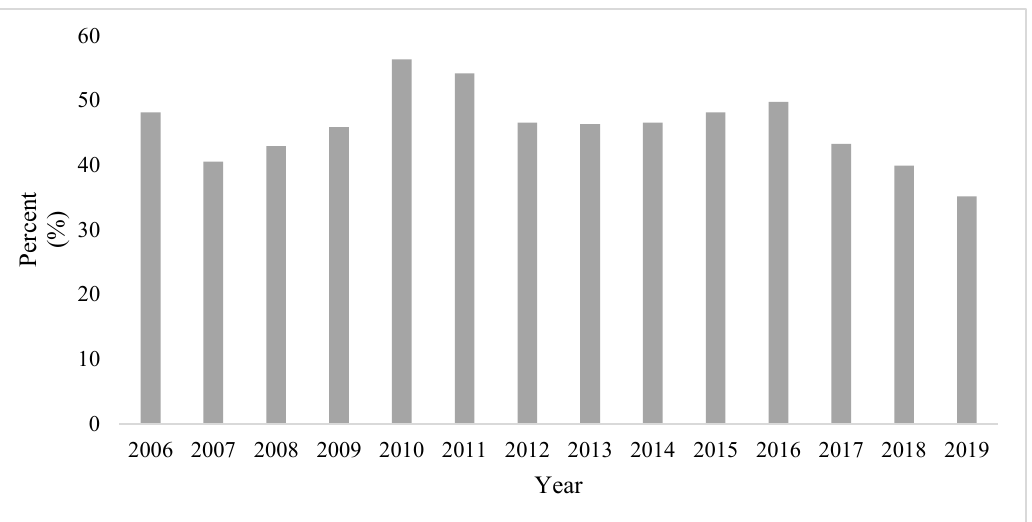
Figure 3. Main payment of insurance organizations to banks and brokers in 2006–2019.